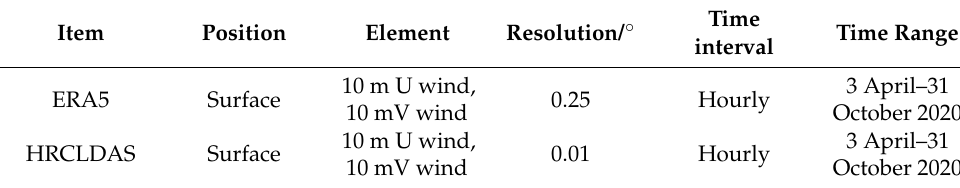
Table 2. Information on ERA5 and HRCLDAS data.